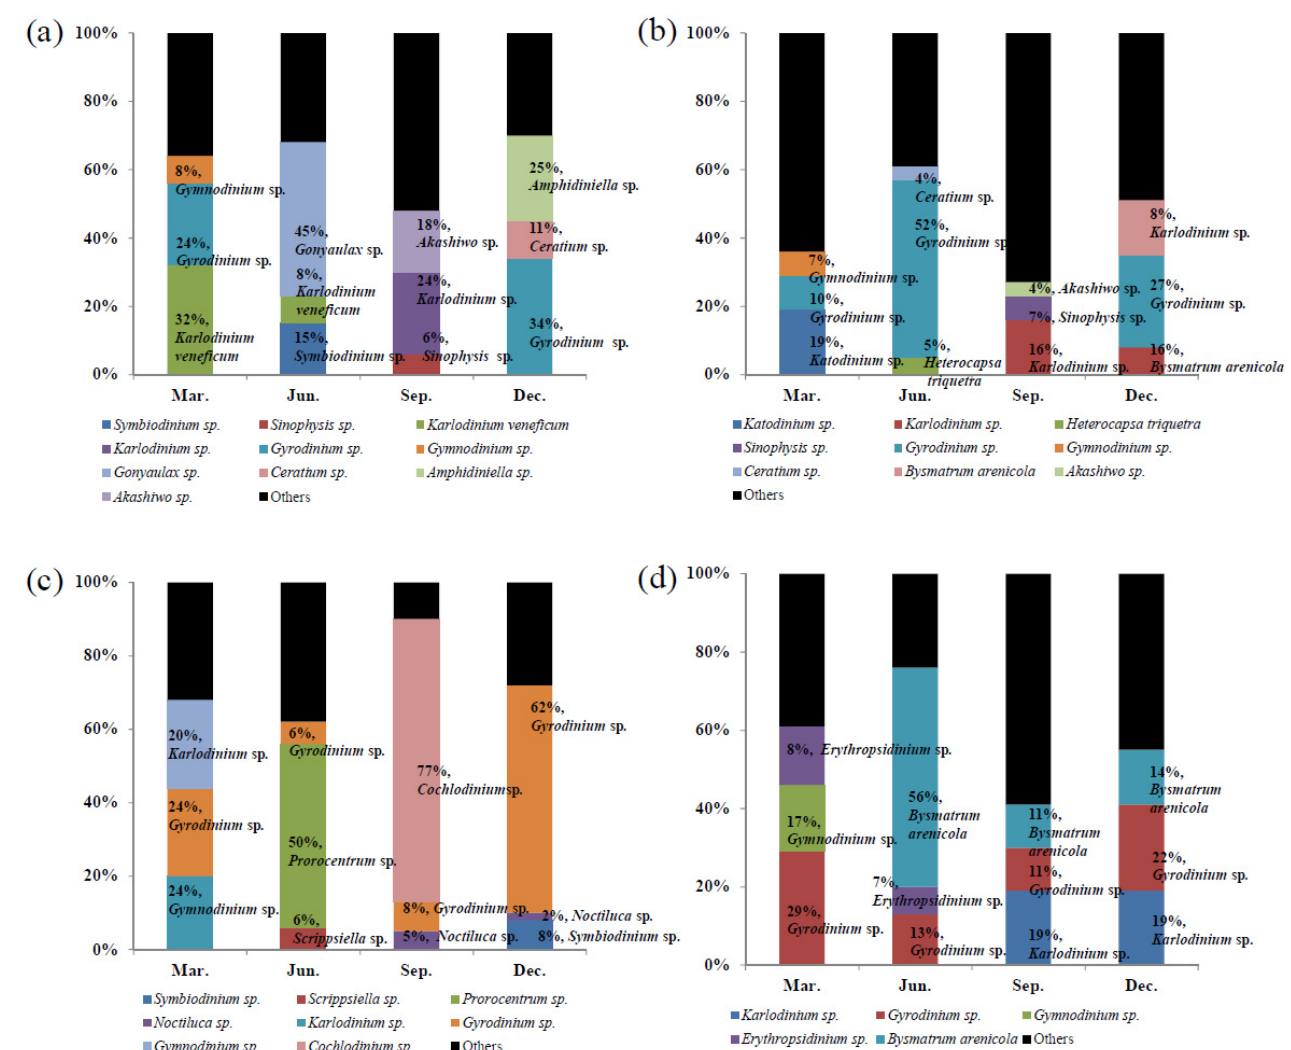
Figure 3. Proportion of top 3 most abundant species in each coastal seawater by metagenome analysis. Gunsan ( a ), Pohang ( b ), Tongyeong ( c ), Seongsan ( d ).